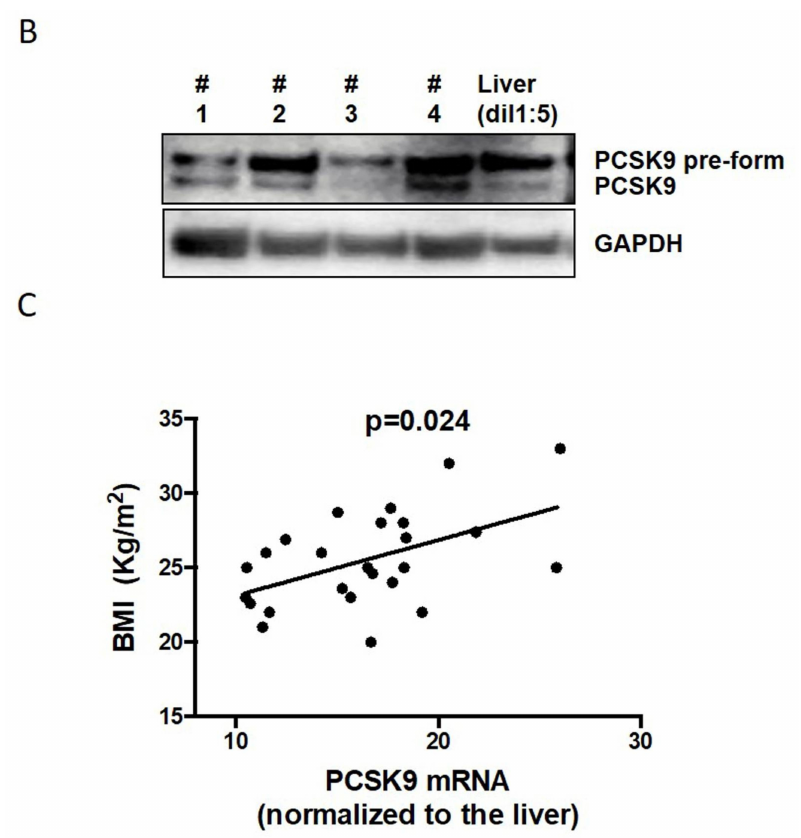
Figure 1. ( A ) PCSK9 gene expression in VAT. Cycle threshold of PCSK9 during real-time gene expression analysis for adipose tissue were between 21 and 24. ( B ) PCSK9 levels in differentiated human adipocytes. ( C ) PCSK9 in VAT according to BMI. # number of